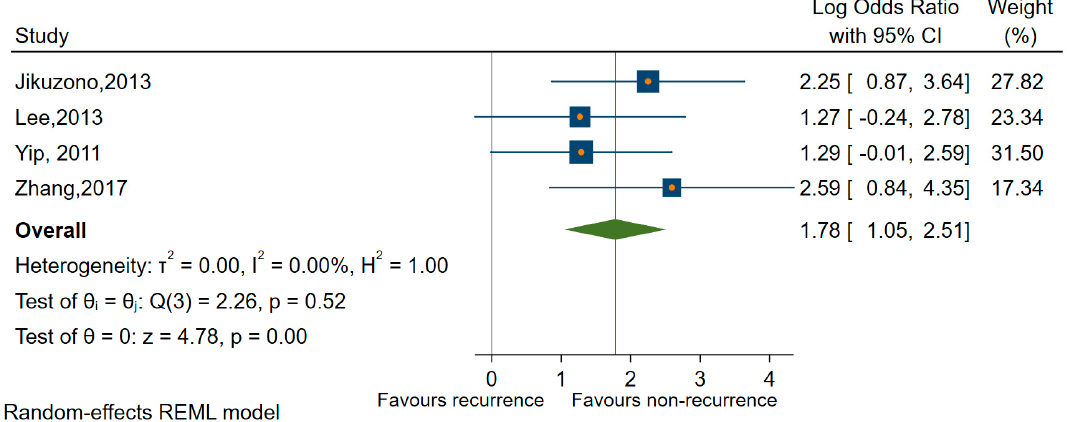
Figure 9. Forest plot of the association between miR-221/222 cluster expression and recurrence.